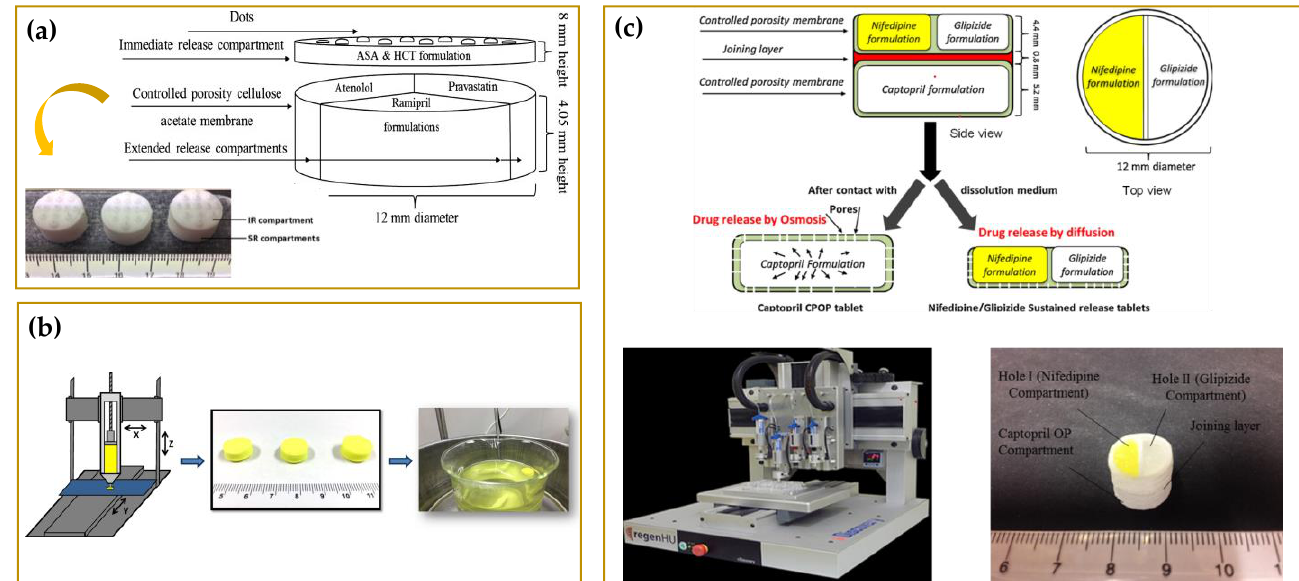
Figure 15. Examples of 3D printed oral dosage forms produced by SSE technique. ( a ) Polypill loaded with five different APIs. Reprinted with permission from reference [126]; copyright (2015) Elsevier B.V.; ( b ) Gastro-floating tablets of dipyridamole. Reprinted with permission from reference [184];